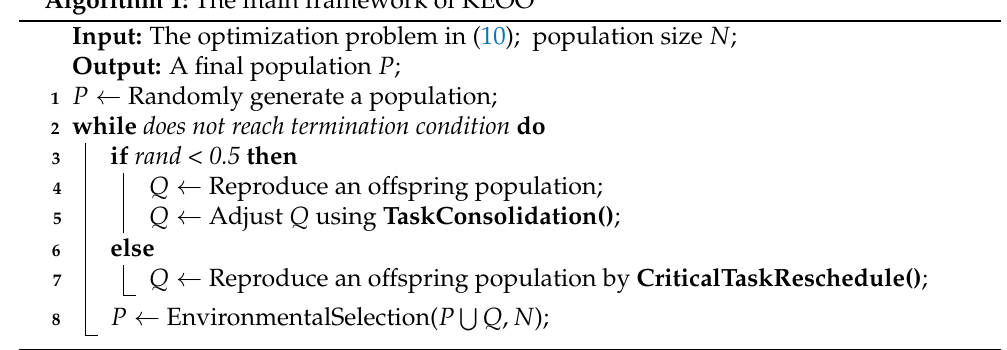
Algorithm 1: The main framework of